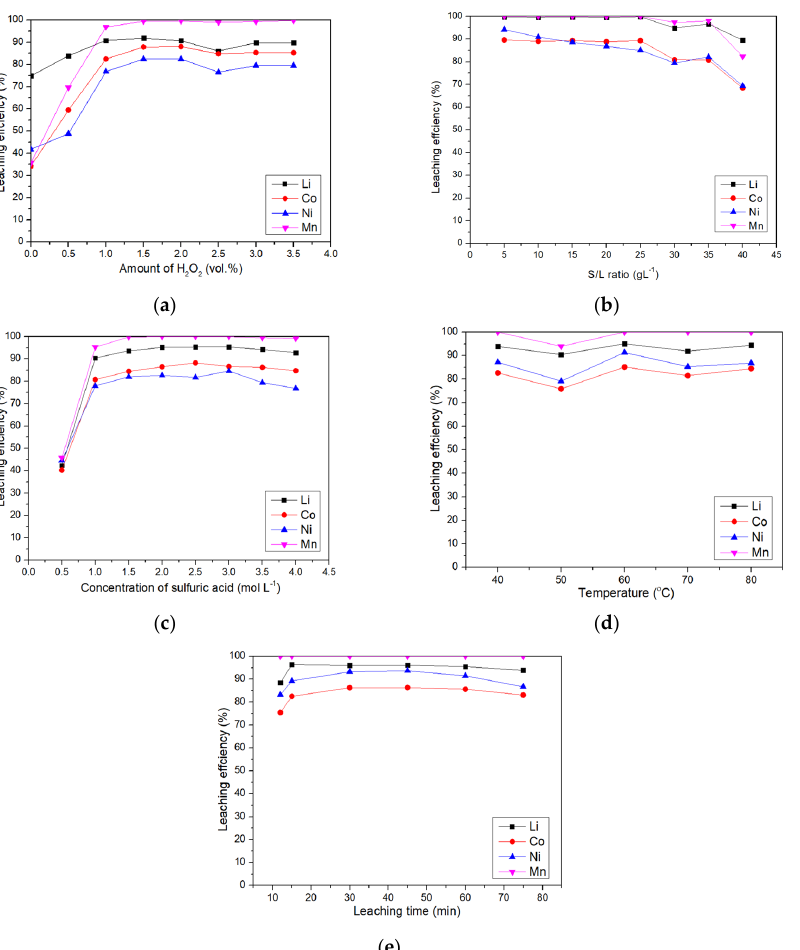
Figure 2. Effect of ( a ) amount of H 2 O 2 added, ( b ) S/L ratio, ( c ) acid concentration, ( d ) temperature, and ( e ) time on leaching efficiency of sulfuric acid.